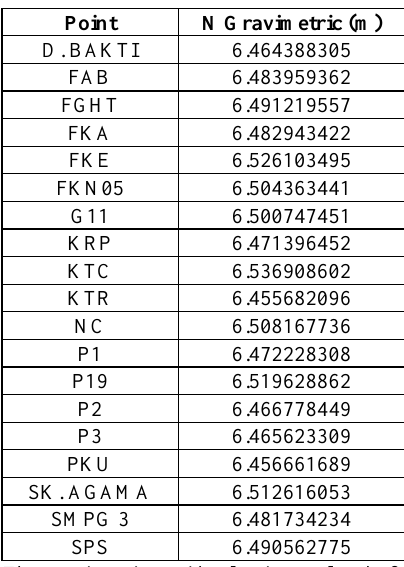
Table 6. The gravimetric geoid value interpolated of extracted from MyGEOID model